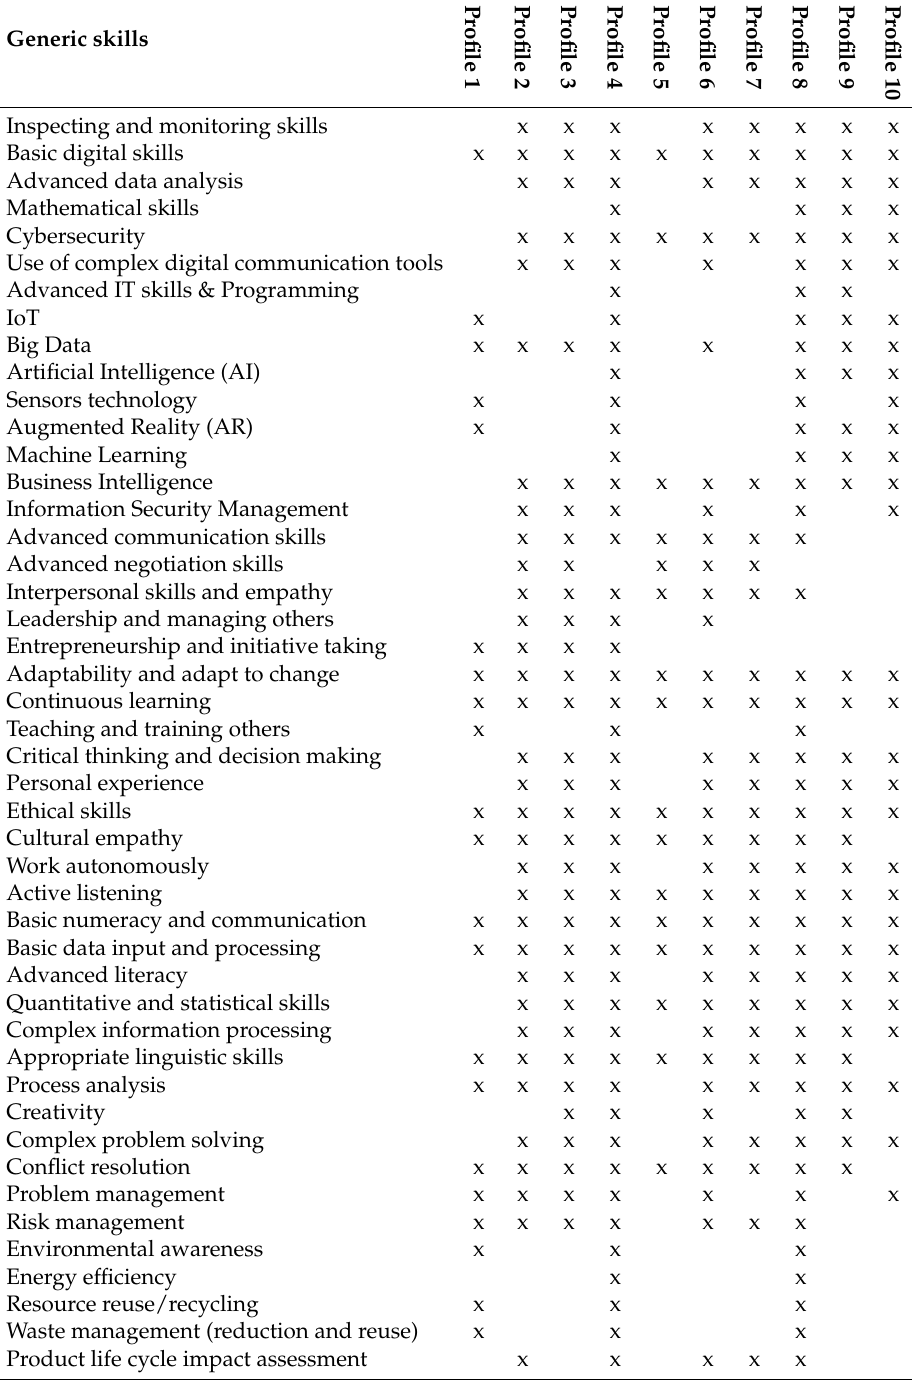
Table 3. Near-future skills for each profile: Generic